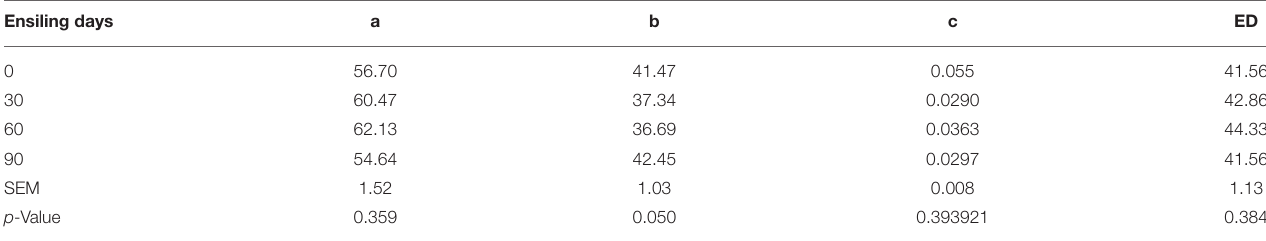
TABLE 10 | Effect of ensiling duration on the rapidly degradable nutrient (a, %), slowly degradable nutrient (b, %), effective degradation rate (c), and the ED (%). Ensiling days